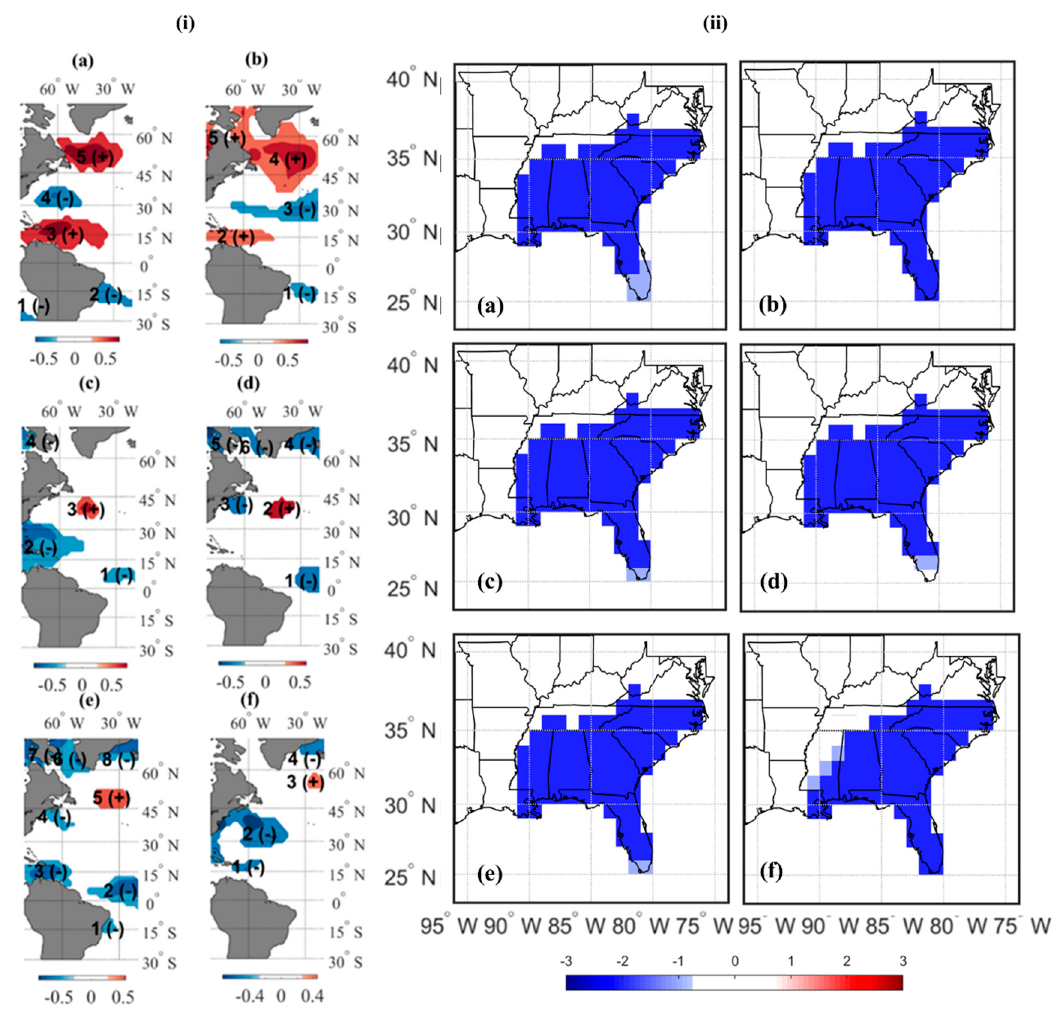
Figure 4. Heterogeneous correlation patterns between ( i ) Atlantic Ocean SST and ( ii ) gridded TWSA of the HUC-03 watershed region. ( a ) June-SST Nov-TWSA; ( b ) July-SST Dec-TWSA; ( c ) Aug-SST Jan-TWSA; ( d ) Sept-SST Feb-TWSA; ( e ) Oct-SST March-TWSA; and ( f ) Nov-SST